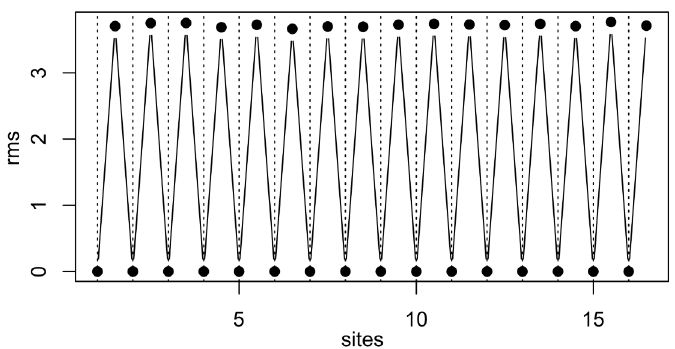
Figure 4 . Rms values of contributions to Im( S ) as a function of lattice site for the undeformed contour. The contributions from integer lattice sites vanish in this